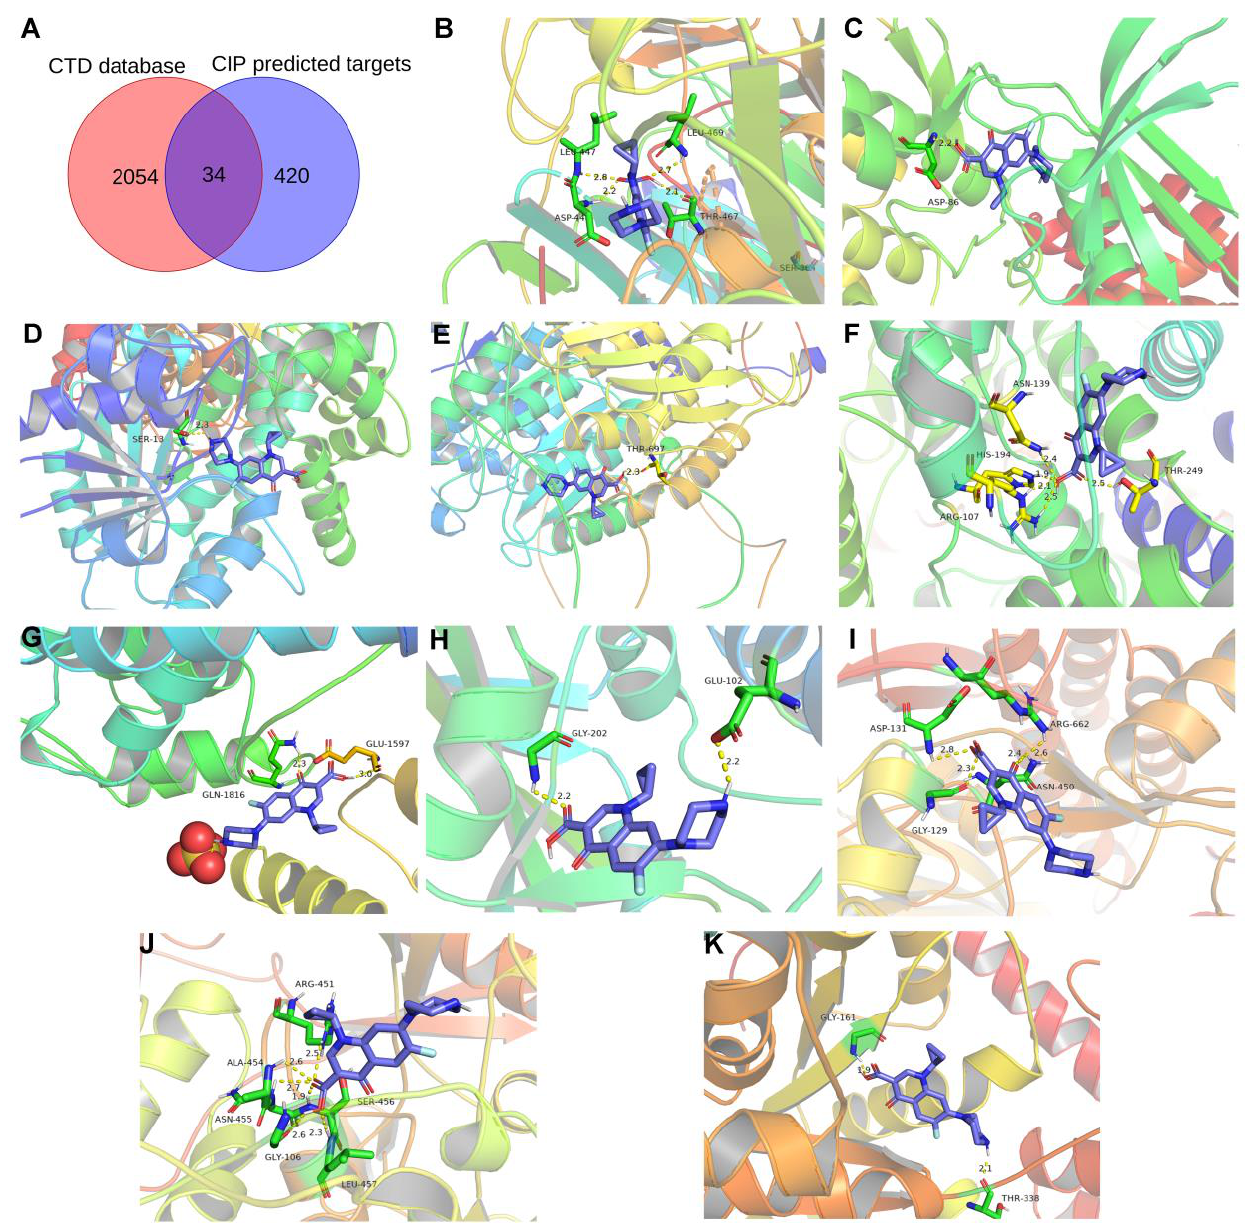
Figure 7. CIP target prediction and molecular docking. ( A ) Venn diagram showing the overlapping components among the predicted CIP targets and CTD-based AAD-related genes. ( B – K ) Molecular docking results for AOC3, CDK5R1, GPD1L, HDAC6, LDHB, MYO5A, PARP1, RAC1, SDHA, and Table 1. Details of the 34 intersecting target genes and their CIP binding energies.